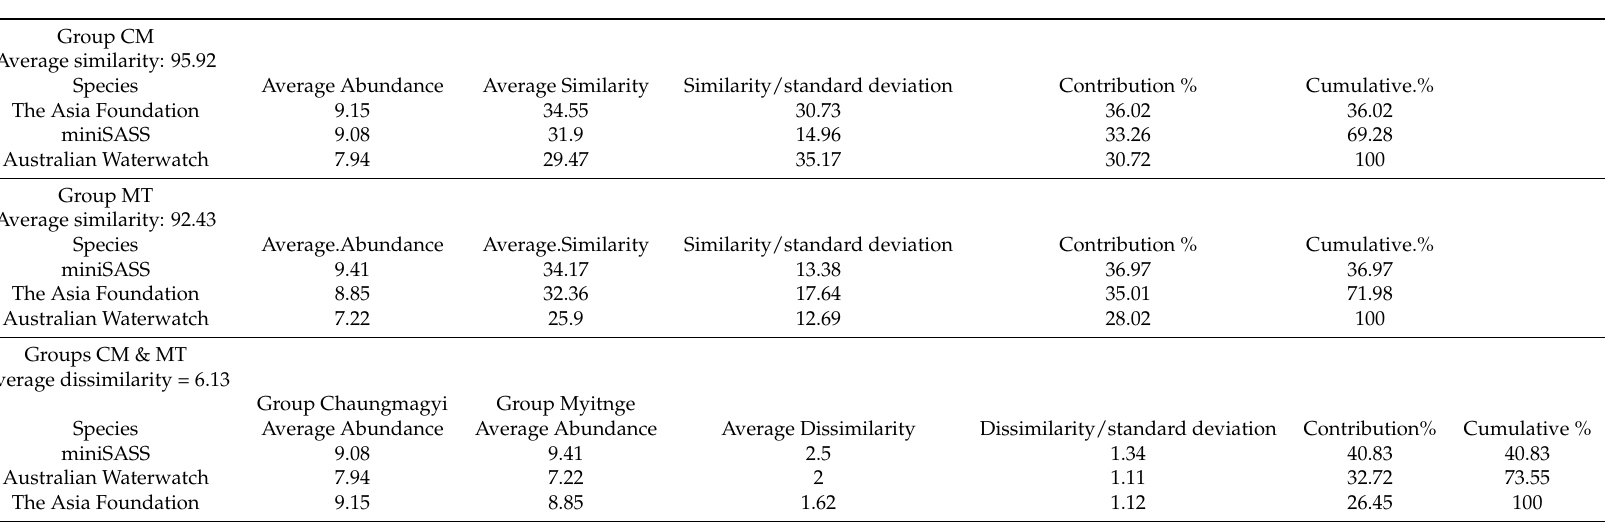
Table 3. The results of Average (dis)similarity percentage and contribution variables by similarity analysis SIMPER routine of PRIMER v6. Group CM Average similarity: 95.92